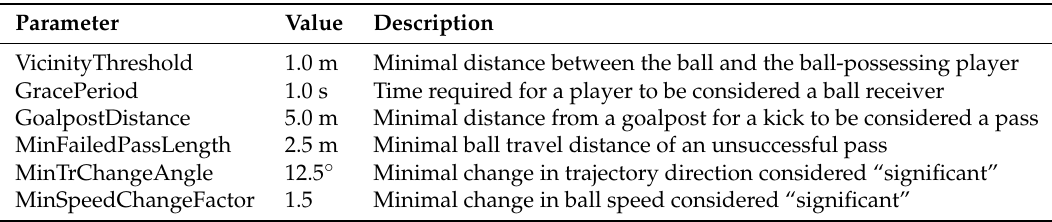
Table 2. Initial experimental setup: